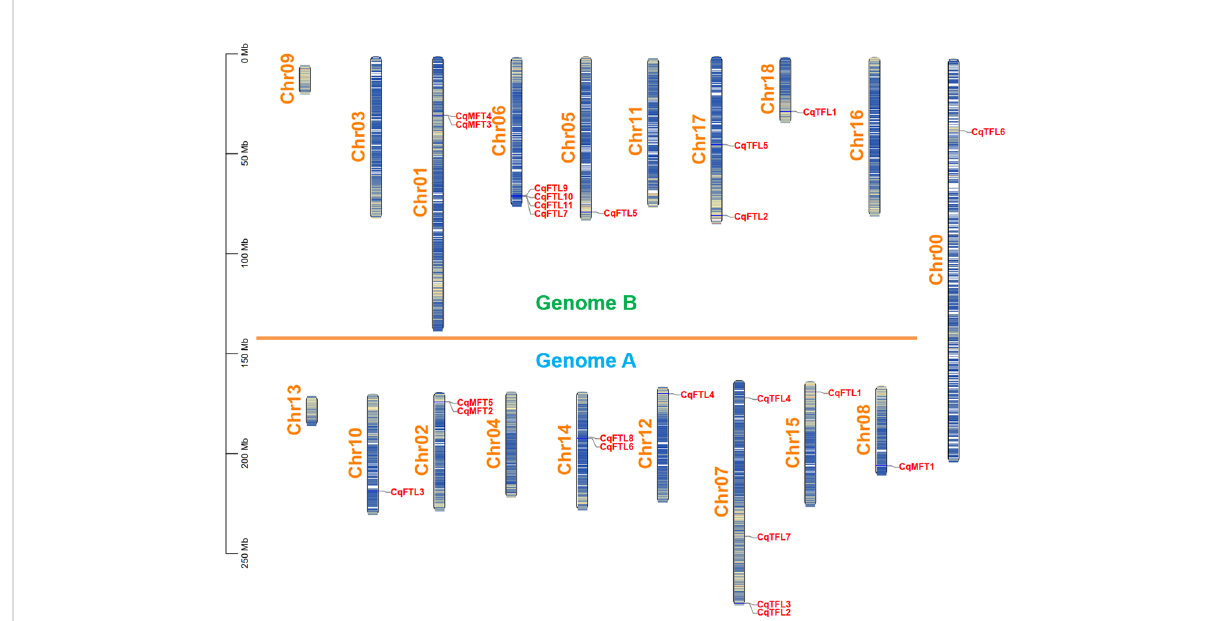
FIGURE 2 Physical location of PEBP genes on quinoa chromosomes. Chromosome segments colored in white and blue indicate high and low gene densities, respectively. All the quinoa chromosomes are divided into sub-genome A and B with the exception of Chr00.